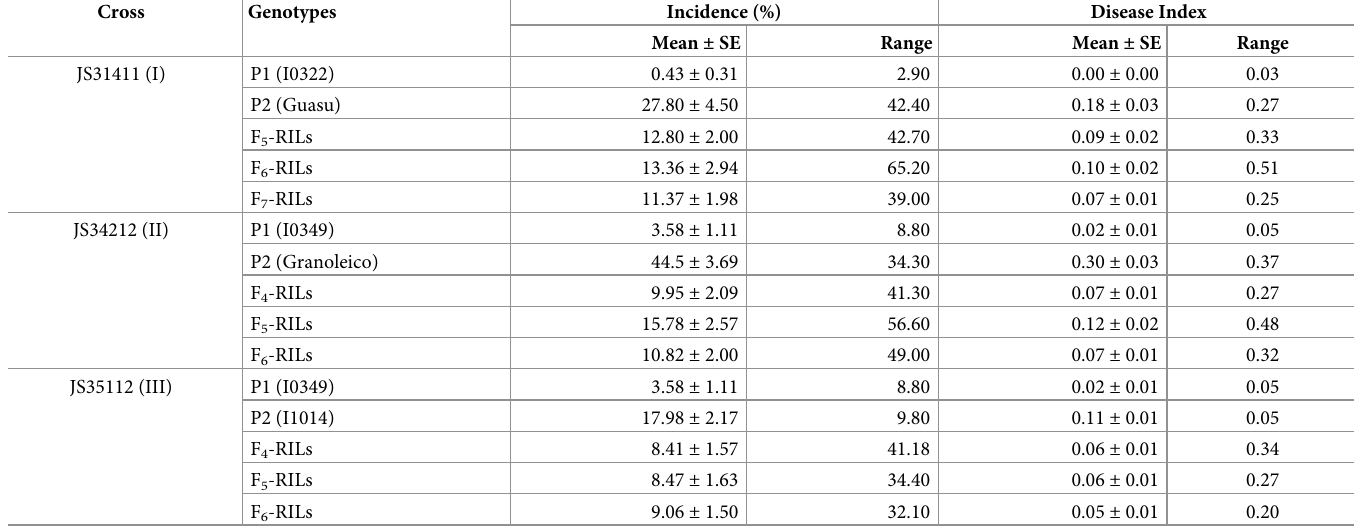
Table 2. Smut disease incidence and disease index mean, standard error (SE), and range for the parental lines (P1, P2) and generations of RILs from the three pea- nut corsses: JS31411 (I), JS34212 (II), and JS35112 (III).